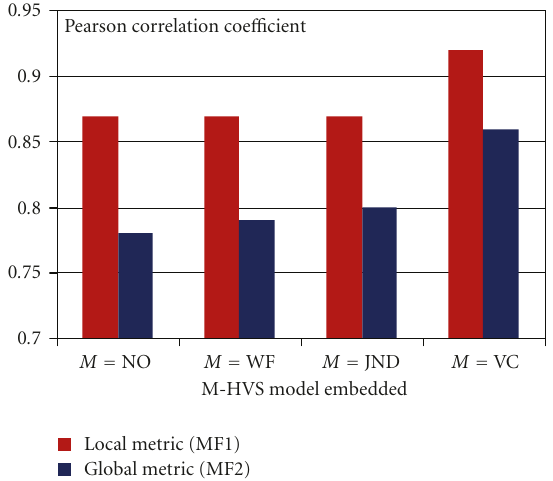
Figure 16: Comparison of the local and global approaches to a blockiness metric, and of metrics with di ff erent HVS models